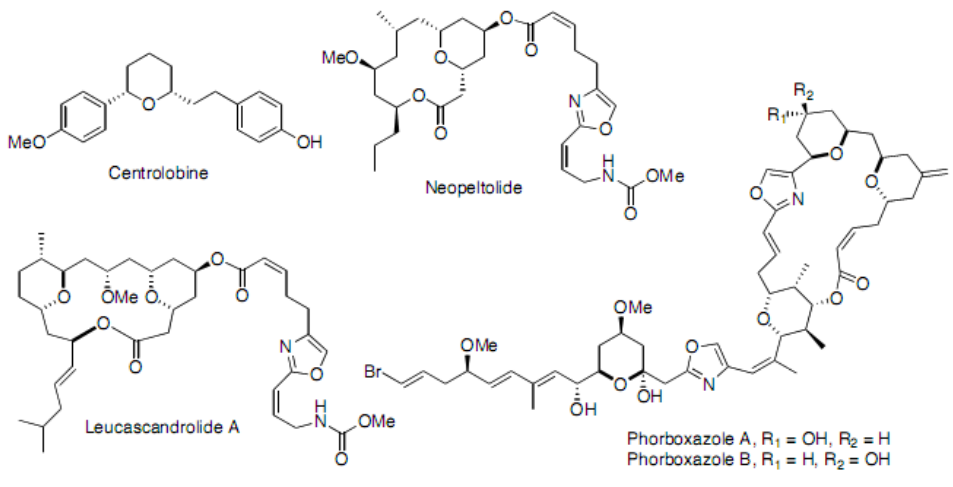
Figure 1. Examples of natural products with a tetrahydropyran core